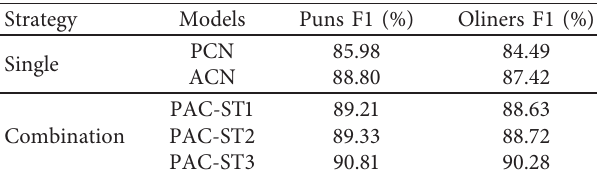
Table 6: Performance of combinational